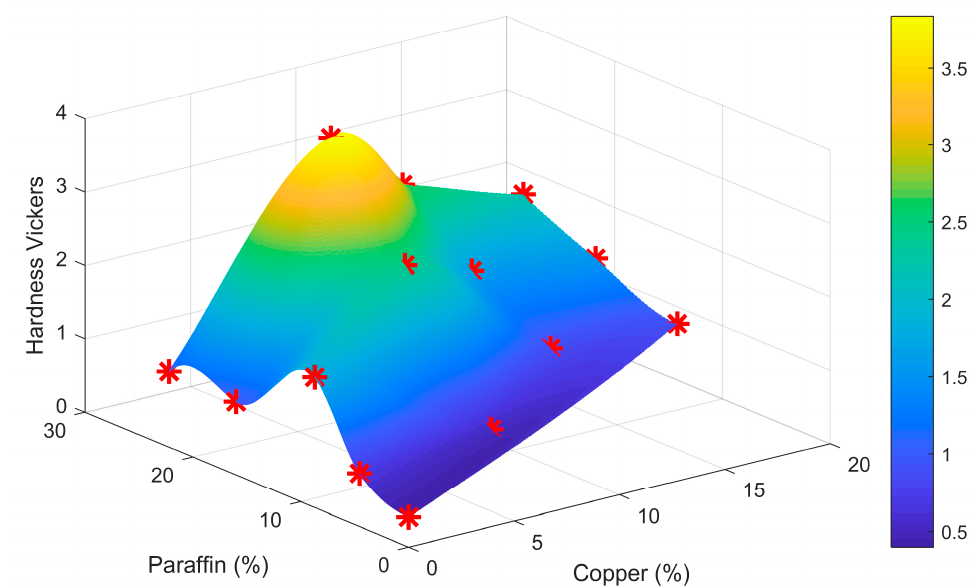
Figure 12. Vickers indentation test results (Hardness Vickers, vertical axis) for different composites (%Cu and Paraffin wax on bottom plane axis).